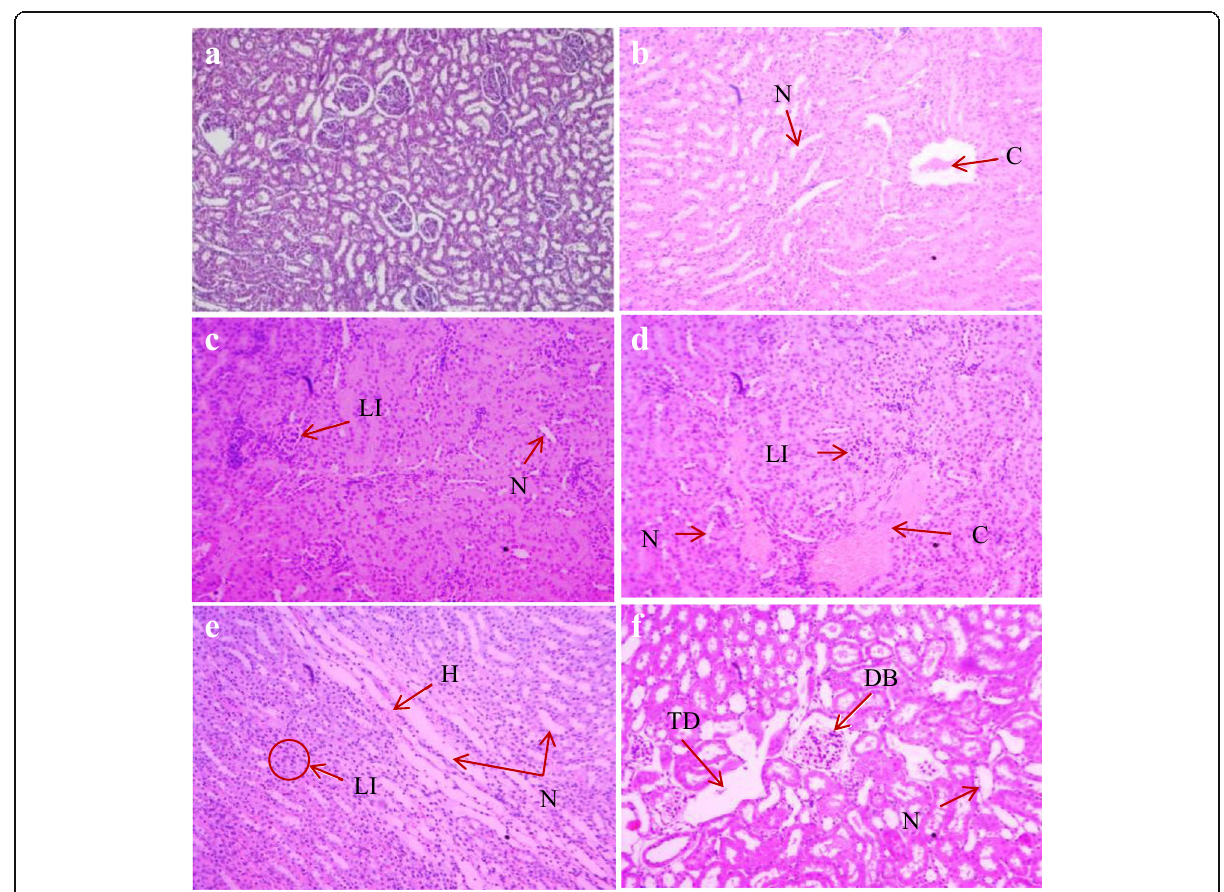
Fig. 2 Kidney histology after 24 h of treatment. Both male and female mice were treated with low and high doses of THJ-2201. a Control kidney section from mice treated with a vehicle. b , c Kidney of male and female mice treated with low dose. d Kidney of female mice treated with 50 mg/Kg/BW. e , f Kidney of male and female treated with high dose (HE, ×